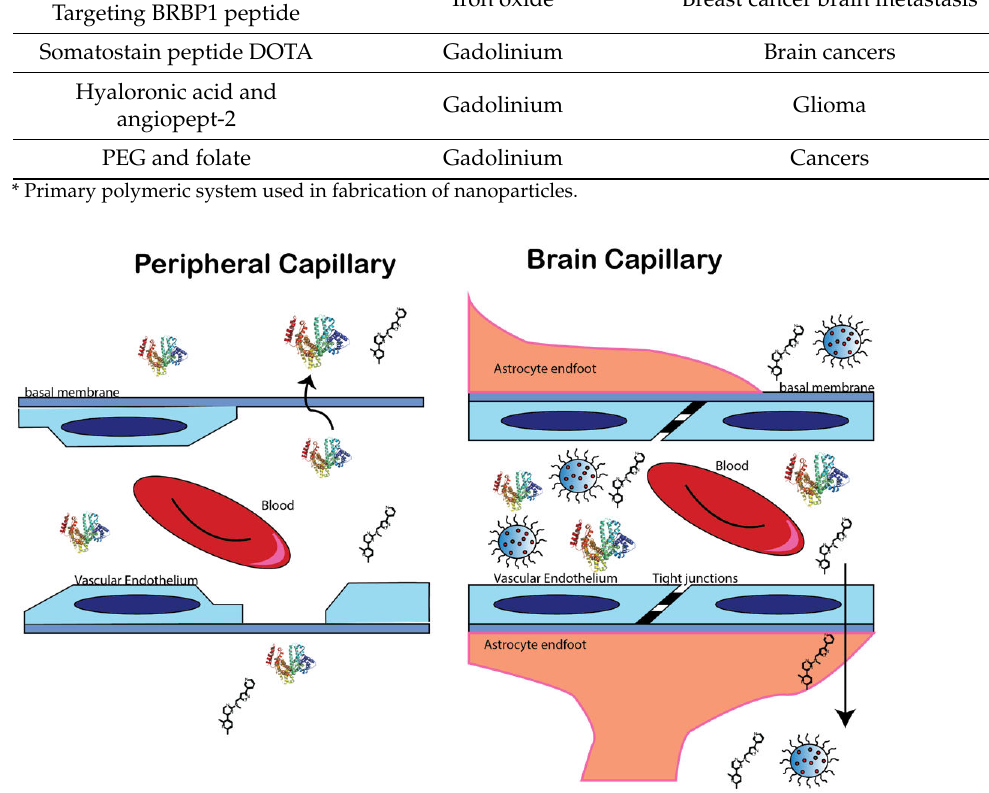
Figure 2. Delivery of theranostic molecules to the brain and tumor with use of nanoparticles. The blood–brain barrier (BBB) is a microvascular unit with tight junctions between the vascular endothelium cells causing selective permeability of small molecules. Use of nanoparticles can increase distribution of compounds to the brain with enhanced therapeutic or diagnostic